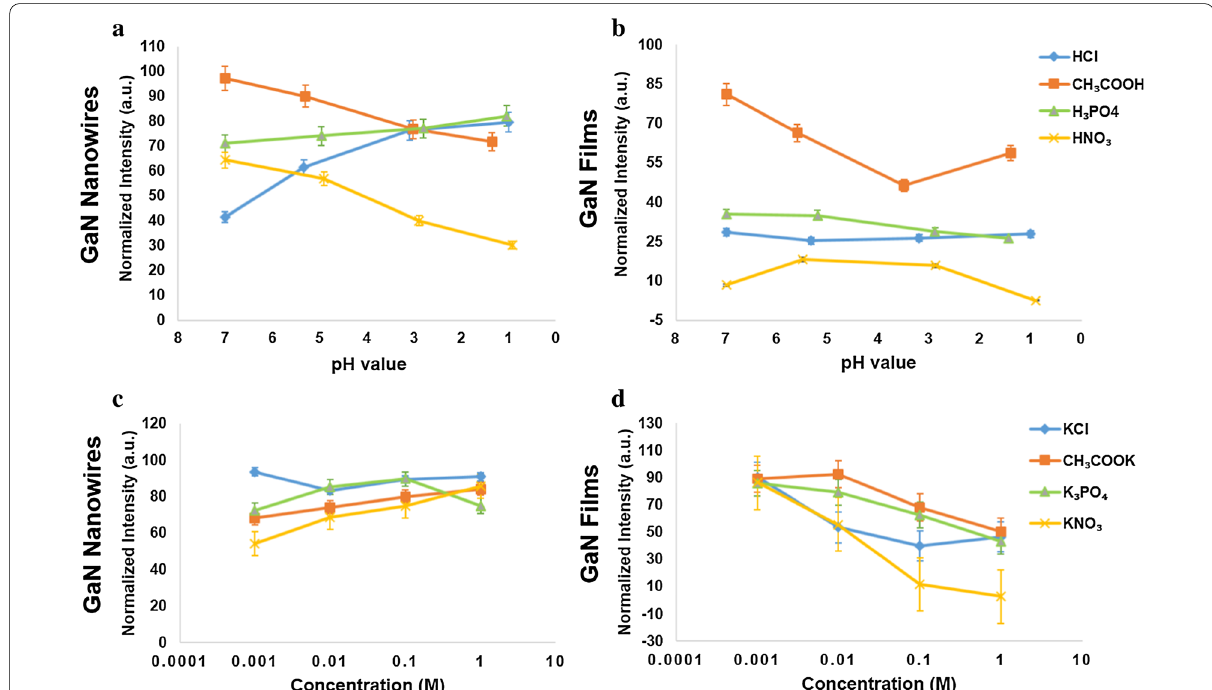
Fig. 1 The PL intensity distribution in different pH values of acidic solutions and salt solutions at different concentrations. He–Ca laser is used here and below as the excitation light source for continuous‑wave output at a wavelength of 325 nm. a The PL response from GaN nanowires with diameters ranging between 60 and 80 nm in acidic solutions. b The PL response from GaN films with ~ 300 μm in thickness in acidic solutions. c The PL response from GaN nanowires in salt solutions with different concentrations. d The PL response from GaN films in salt solutions with different